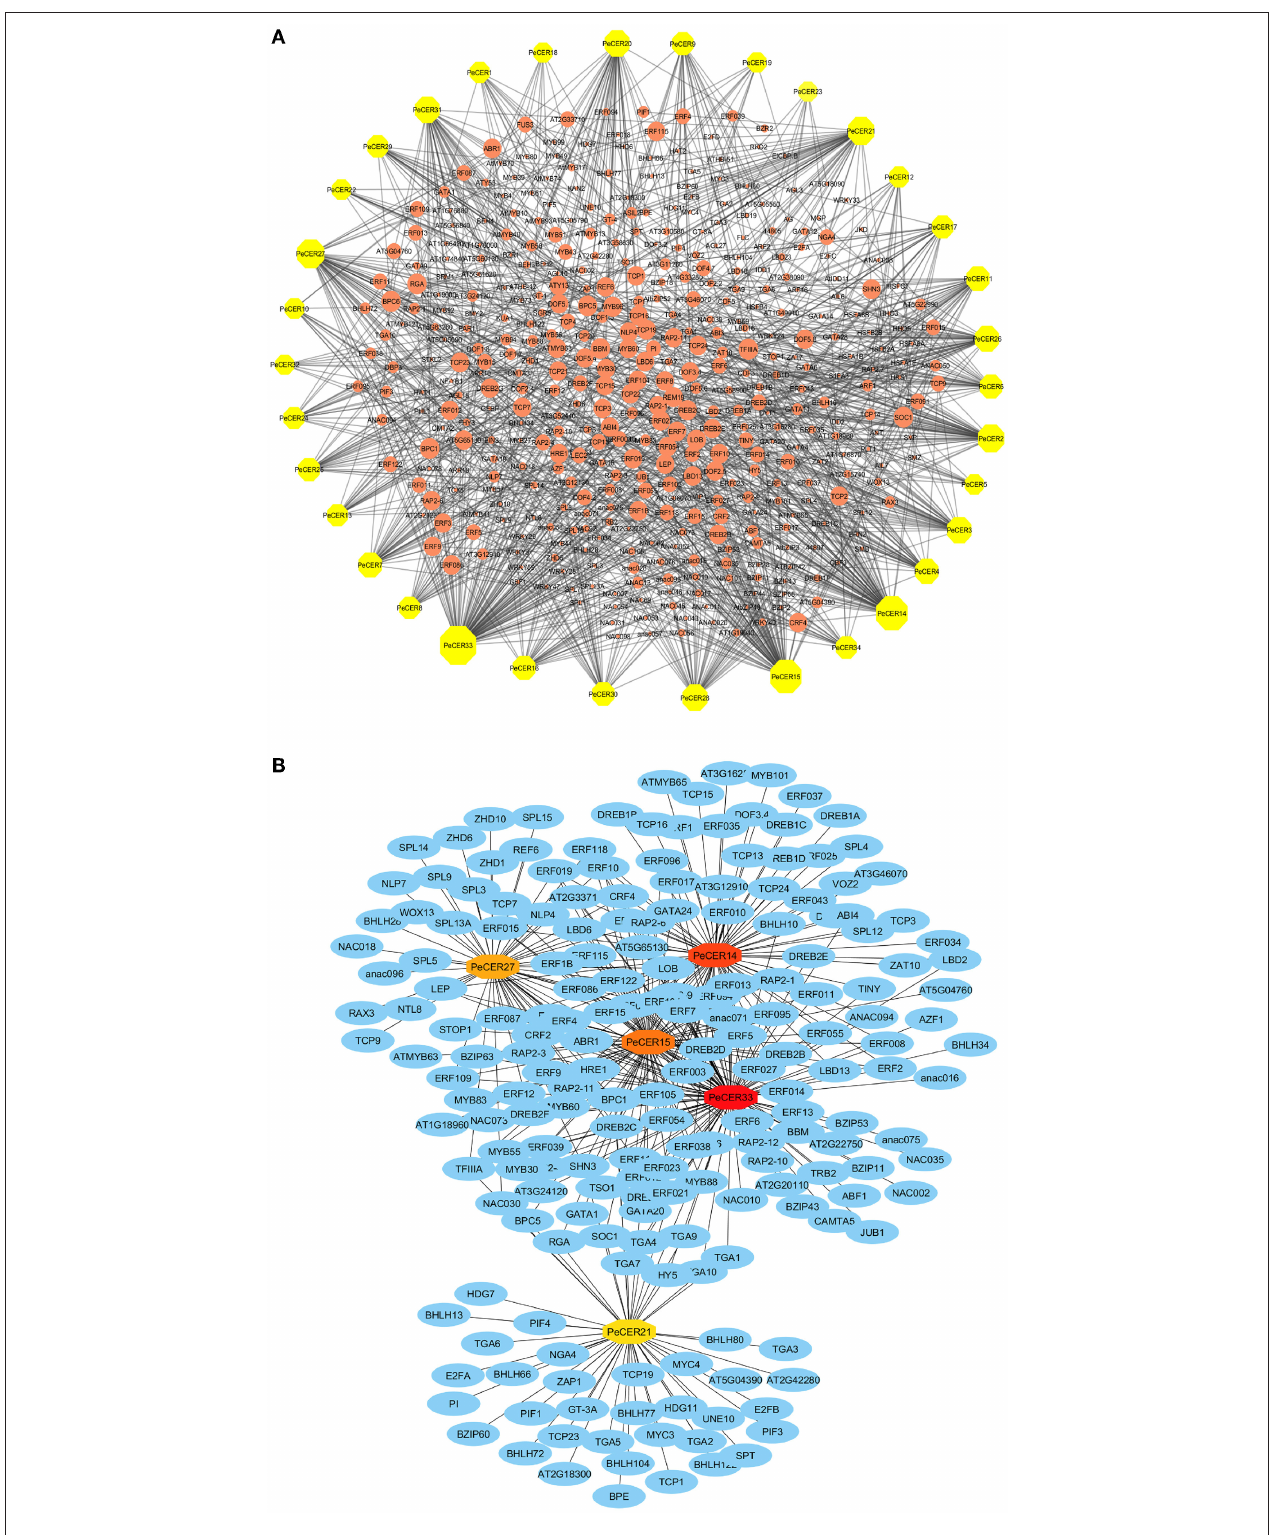
FIGURE 7 | Putative transcription factor regulatory network analysis of the PeCER genes. (A) Orange peel circular nodes represent transcription factors; yellow octagonal nodes represent PeCER genes, and node size represents the degree of interaction between nodes based on degree value. (B) Top 5 highly enriched and targeted PeCER genes with TFs are shown, blue nodes represent the TFs, dark red to light red colors show the PeCER genes, and darker PeCER node color shows highly enriched and vice versa.